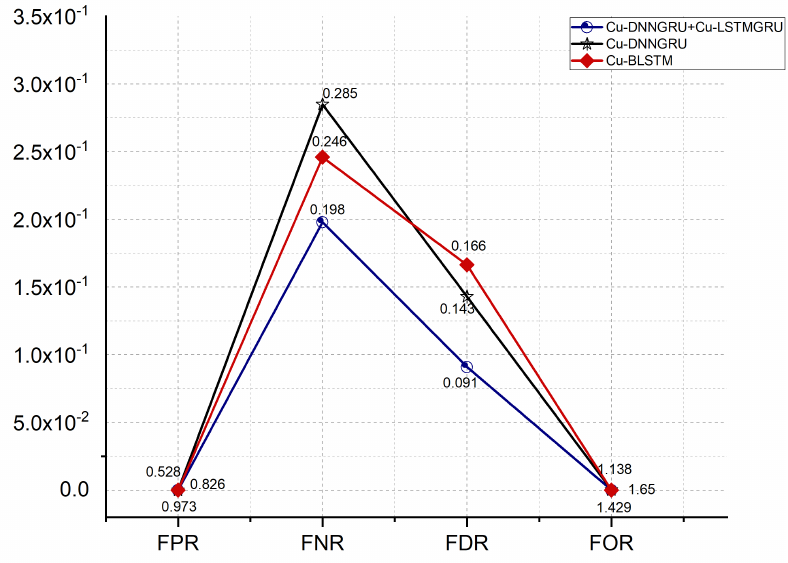
Figure 6. False positive rate (FPR), false negative rate (FNR), false discovery rate (FDR) and false omission rate (FOR).